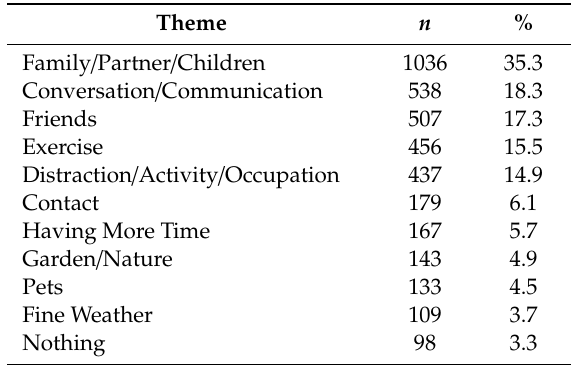
Table 5. What does help you during the COVID-19 * pandemic?